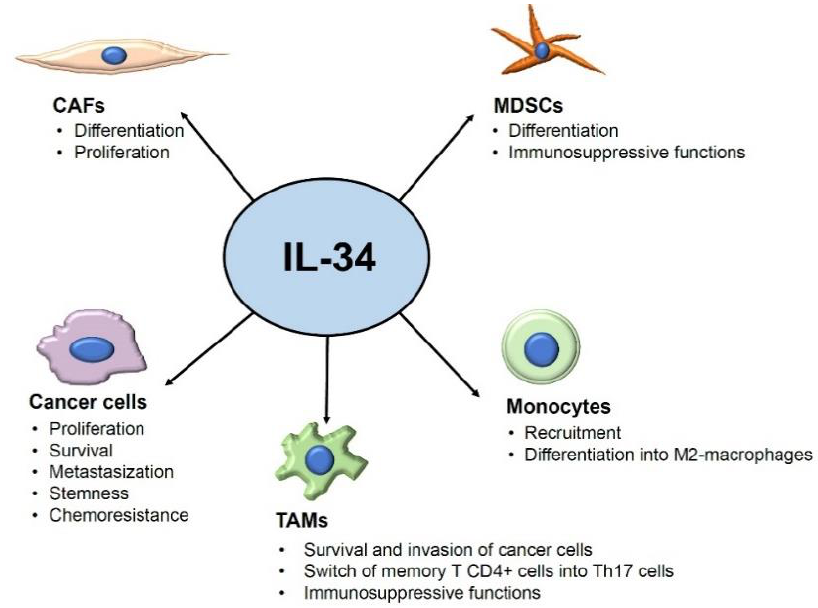
Figure 1. Overview of the tumor-promoting effects of IL-34 on its target cells. Arrows indicate the targets of IL-34 and the IL-34-driven tumor effects. Abbreviations: CAFs: cancer-associated fibroblasts; MDSCs: myeloid-derived suppressor cells; TAMs: tumor-associated macrophages.